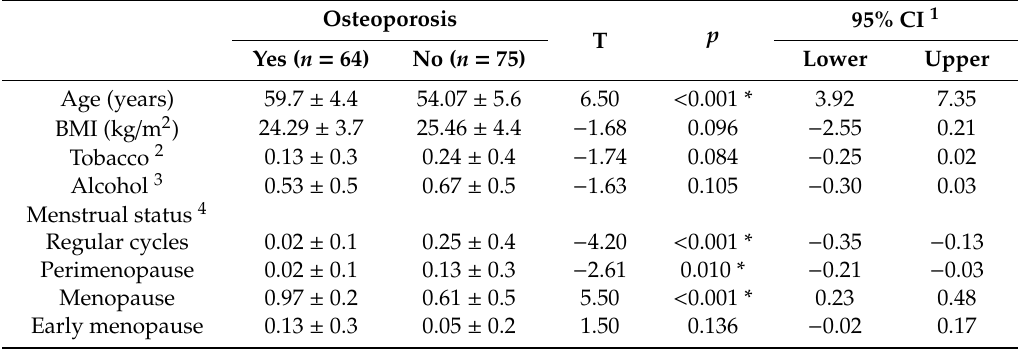
Table 1. Descriptive data on the cohort of women indicating the population means of anthropometric, alcohol and tobacco consumption, and menstrual status in participating women by osteoporosis status.